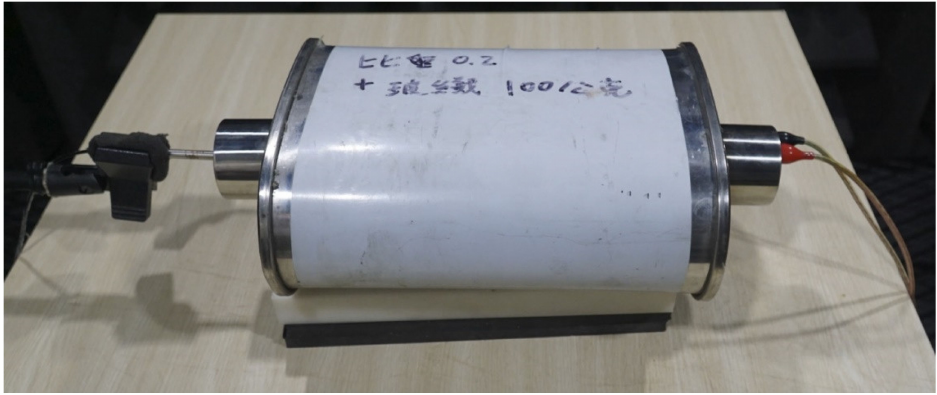
Figure 6. A foam concrete muffler at anechoic